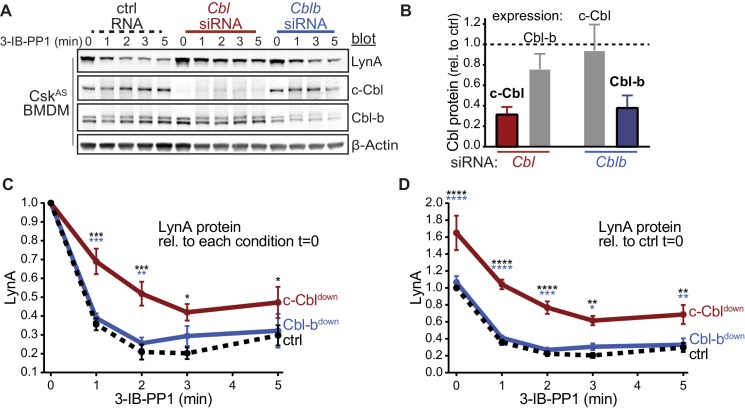
siRNA knockdown of c-Cbl expression in macrophages leads to steady-state upregulation and delayed degradation of LynA protein.(A) Immunoblots showing LynA, c-Cbl, and Cbl-b protein in CskAS BMDMs transfected with non-targeting RNA (ctrl) or with siRNA constructs targeting Cbl or Cblb mRNA. Rested cells were treated with 3-IB-PP1 for the indicated times; β-Actin is shown as a loading control. (B–D) Quantification of relative c-Cbl, Cbl-b, and LynA protein, corrected for total protein content (TPS). SEM, n = 3. (B) Quantification of c-Cbl protein (red) and Cbl-b protein (blue), reported relative to their expression in ctrl BMDMs (dotted line). Remaining expression of the other Cbl family member is shown in gray. (C–D) Quantification of LynA, reported relative to the steady-state level in each siRNA condition (C) or relative to the level in the ctrl sample at steady state (D) in ctrl (black dotted), c-Cbldown (red), and Cbl-bdown (blue) samples. Sig. from ANOVA2-Tukey: [c-Cbldown vs. ctrl, black asterisks], [c-Cbldown vs. Cbl-bdown, blue asterisks]; ****p<0.0001, ***p=0.0001–0.0005, **p=0.0015–0.0058, * P=0.0105–0.0451. Other pairs ns. Refer to Figure 1—figure supplement 2—source data 1.10.7554/eLife.46043.005Figure 1—figure supplement 2—source data 1.Quantification of Cbl and LynA proteins in BMDMs deficient in c-Cbl or Cbl-b.